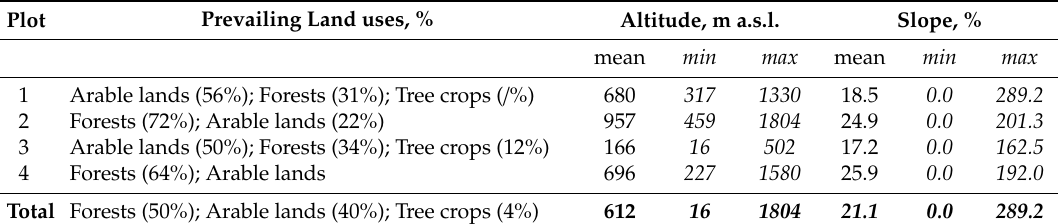
Table 2. Morphological and vegetation characteristics of the plot